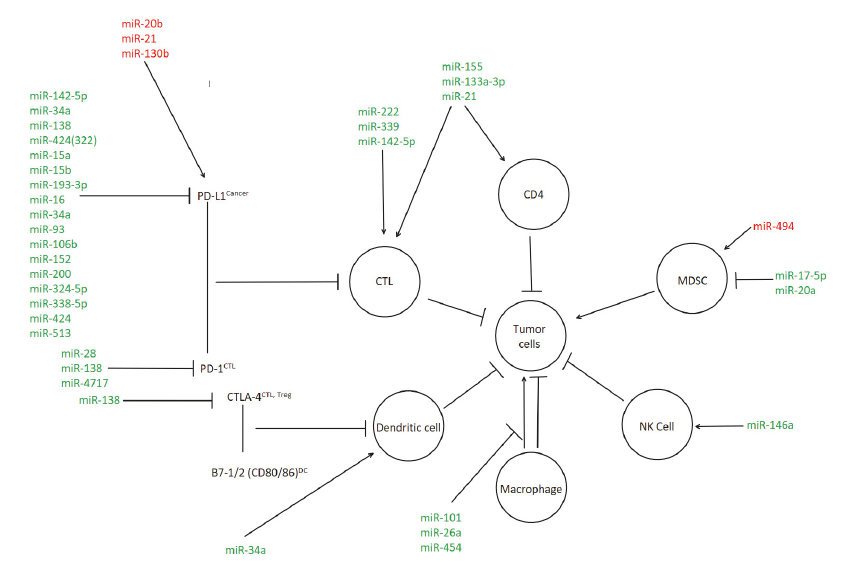
Figure 1: The miRNA modulation of cellular immunity in gastrointestinal cancers. Red denotes procancer miRNA interactions while green denotes anticancer